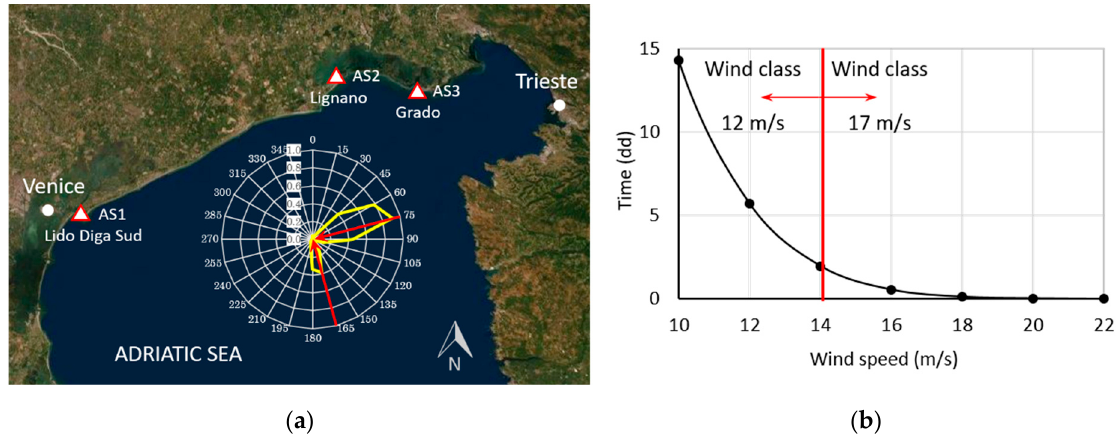
Figure 9. Wind speeds higher than 10 m/s in the northern Adriatic Sea: ( a ) polar chart of the relative frequencies according to the data of the anemometric stations indicated by triangles; ( b ) duration curve.